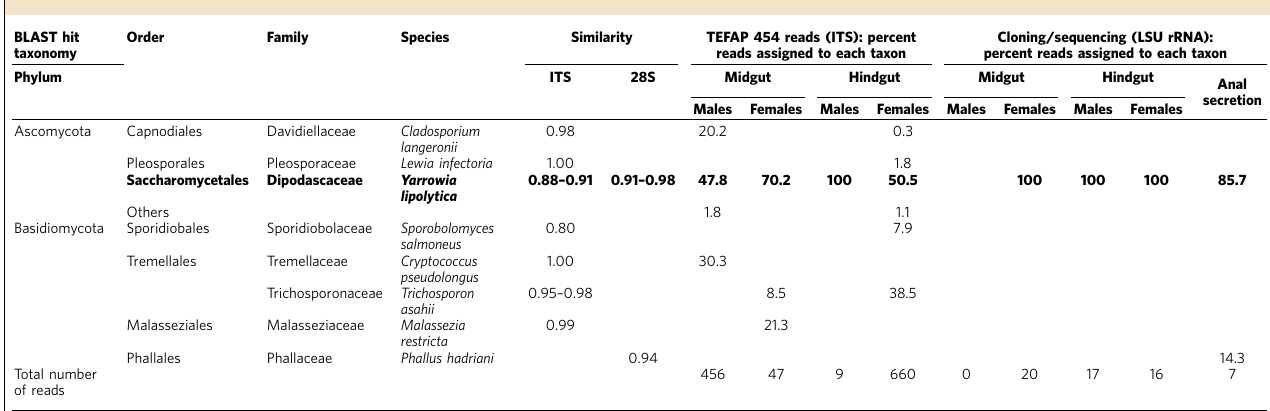
Table 1 | Fungal community in adult N. vespilloides and their anal secretions. BLAST hit Order Family Species Similarity TEFAP 454 reads (ITS): percent taxonomy